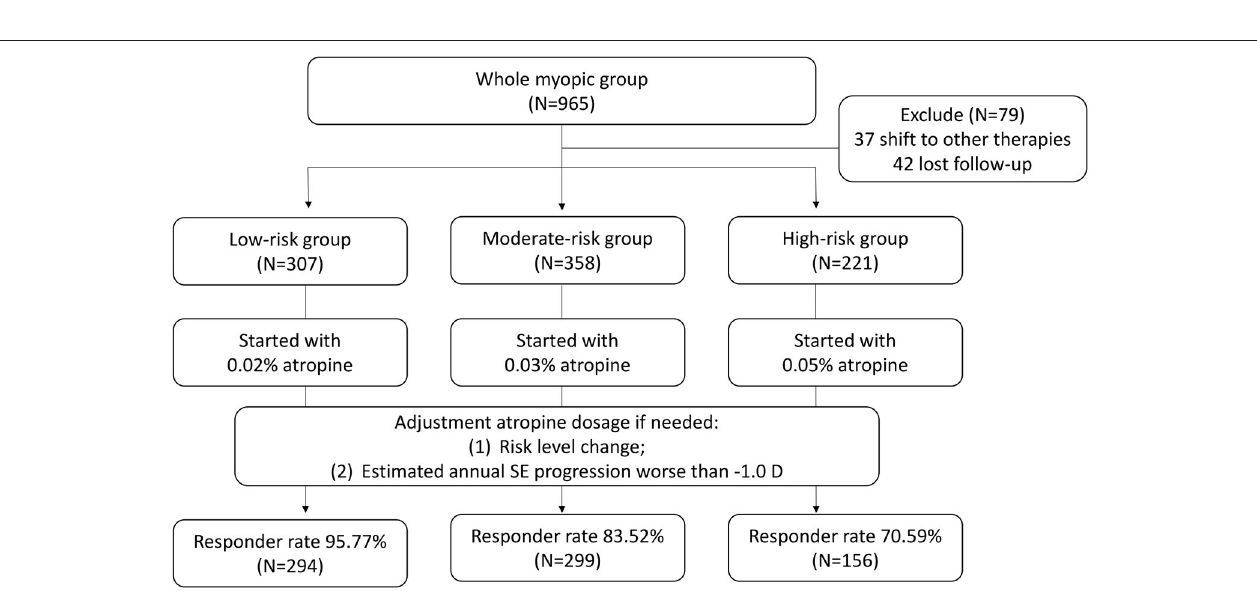
FIGURE 1 | Axial length growth chart among Taiwanese children separated by sex from the first part of this study. The charts were further subclassified the percentiles into three risk categories: below the 50th percentile, low risk (green color); 50th to 90th percentile, moderate risk (yellow color); and above the 90th percentile, high risk (red color).